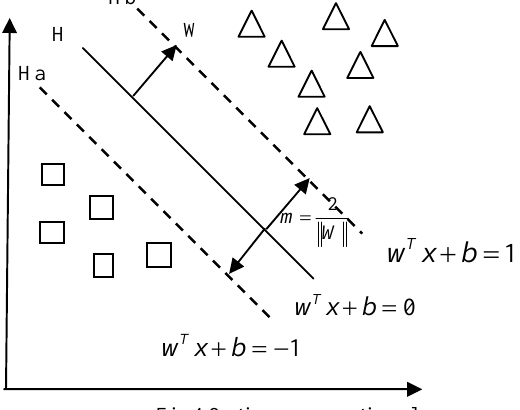
Fig.4 Optimum separation plane